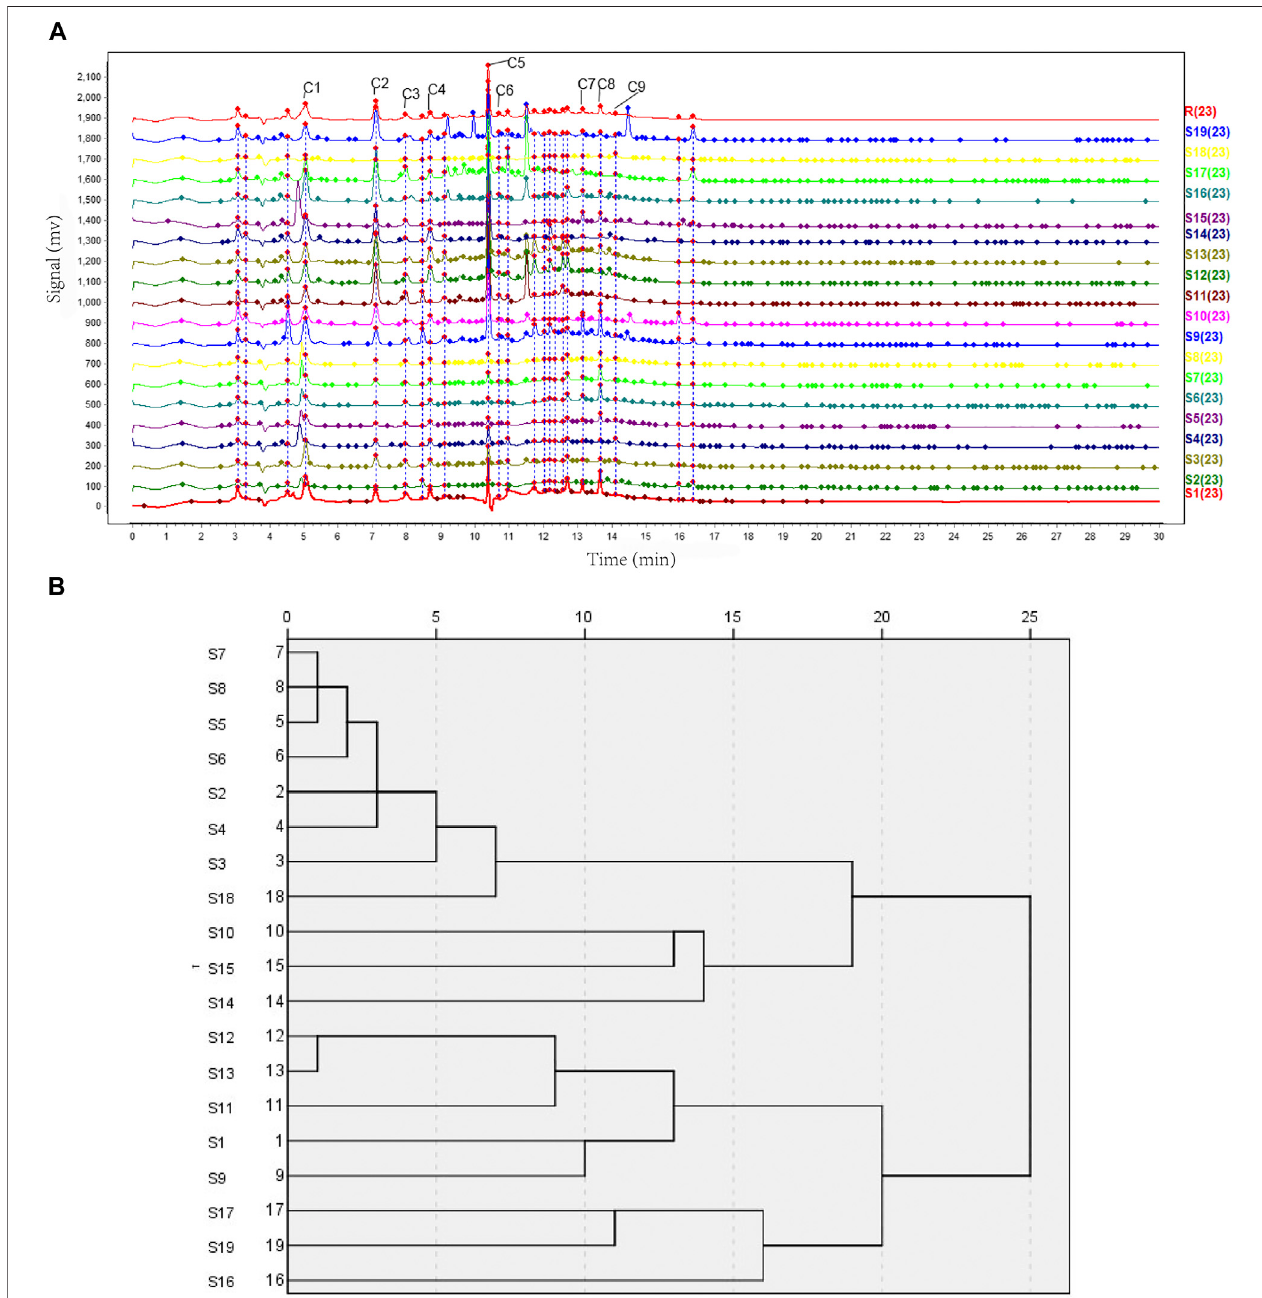
FIGURE 5 | UHPLC fi ngerprints analysis and hierarchical cluster analysis. (A) The UHPLC fi ngerprints of 19 batches of OH samples (S1 – S19) and reference standard fi ngerprint (R). C1 — Monotropein. C2 — Deacetylasperulosidic acid. C3 — 6,7-dihydroxy-7-(hydroxymethyl)-1-(((2S,3R,4S,5S,6R)-3,4,5-trihydroxy-6- (hydroxymethyl)tetrahydro-2H-pyran-2-yl)oxy)-1,4a,7,7a-tetrahydrocyclopenta [c]pyran-4-carboxylic acid. C4 — 3-hydroxy-4-(((2S,3R,4S,5S,6R)-3,4,5-trihydroxy-6- ((sulfooxy)methyl)tetrahydro-2H-pyran-2-yl)oxy)benzoic acid. C5 — Asperulosidic acid. C6 — Scandoside. C7 — Hedanthroside C. C8 — Hedanthroside B. C9 — Ferulic acid. (B) Clustering analysis graph of the 19 batches of OH.